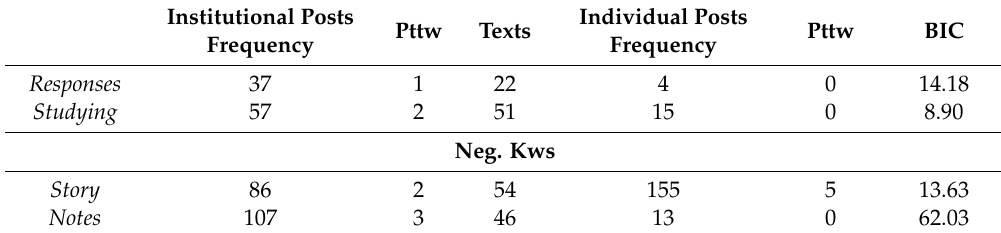
Table 5. Institutional vs. individual blog posts: other